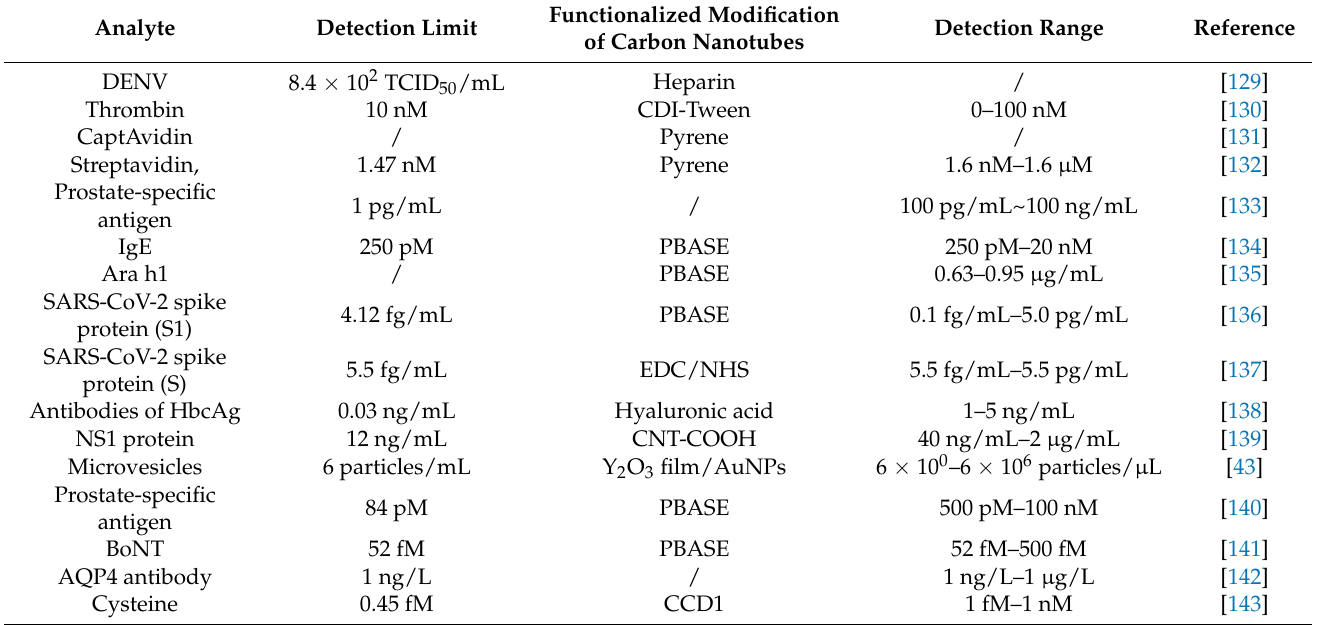
Table 2. Protein detection based on a